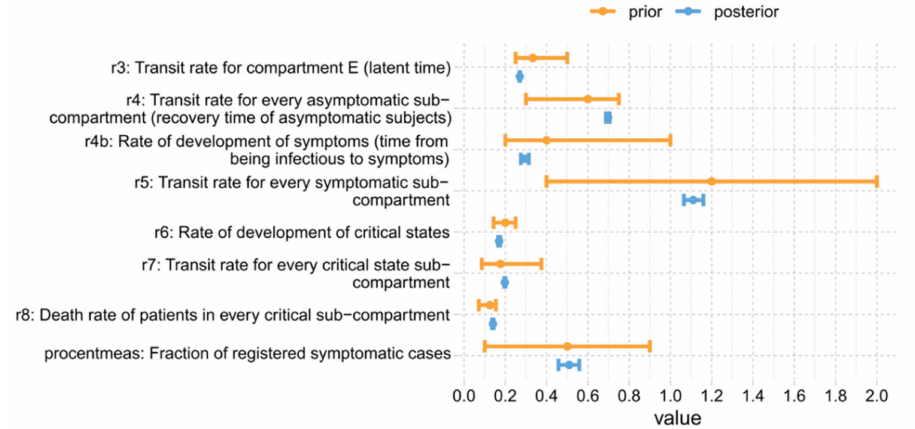
Figure 4. Comparison of prior and posterior values of estimated parameters of the SECIR model. We present prior vs. posterior distributions of estimated parameters of the SECIR model. Ranges for priors represent assumed minimum and maximum values. Ranges for posteriors represent 95%-confidence intervals. Numbers are provided in Table A8 from Appendix